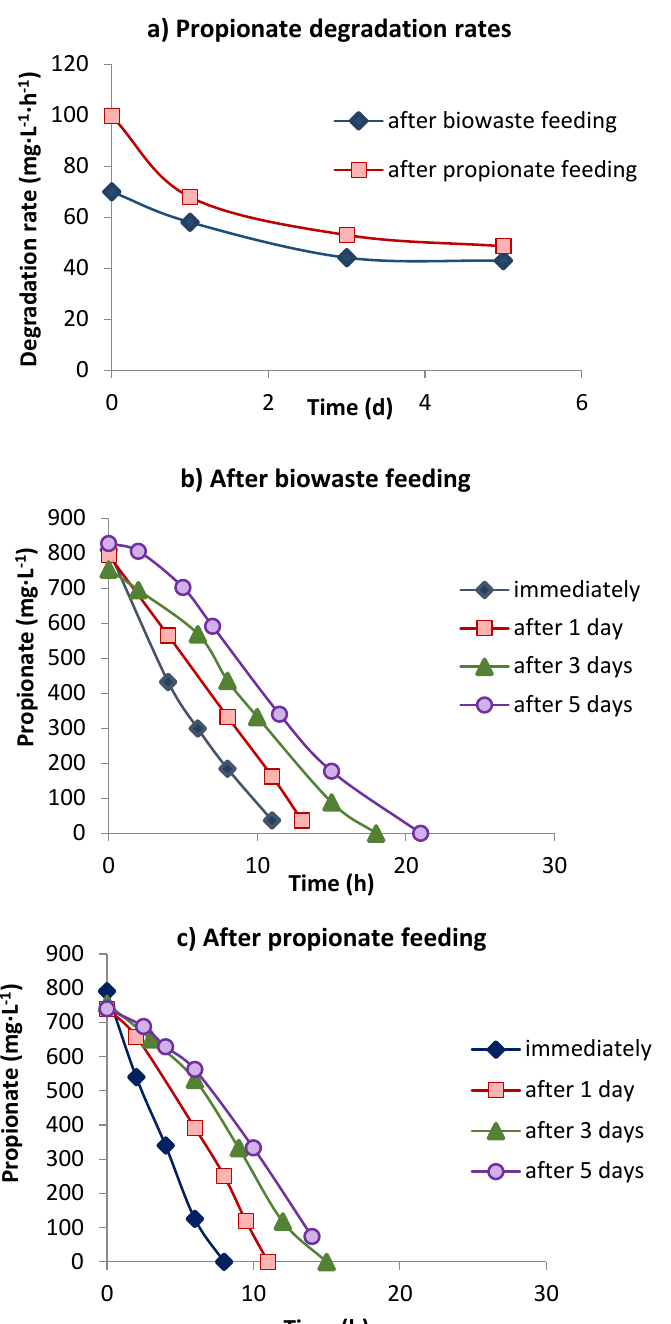
Figure 5. Propionate degradation rates ( a ) and degradation activity immediately following starvation in effluent of reactor 4 or after 1–5 days, after biowaste ( b ) or propionate feeding ( c